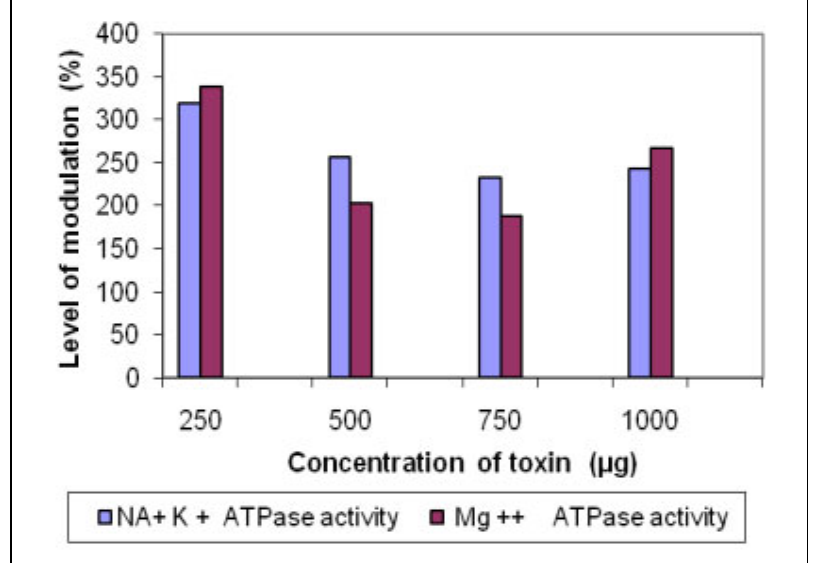
Figure 2. Modulation of Na + -K + ATP-ase and Mg ++ ATP-ase activity by the chloroform-methanol (2:1) extract of Halichondria